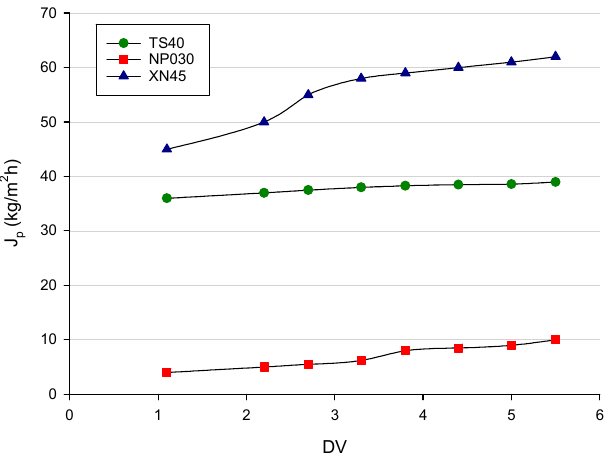
Figure 2. Diafiltration of clarified apple juice with selected membranes. Permeate flux as a function of diafiltration volume (Operating conditions: TMP, 25 bar; Qf, 7 L/min; T, 25 ± 1 °C).